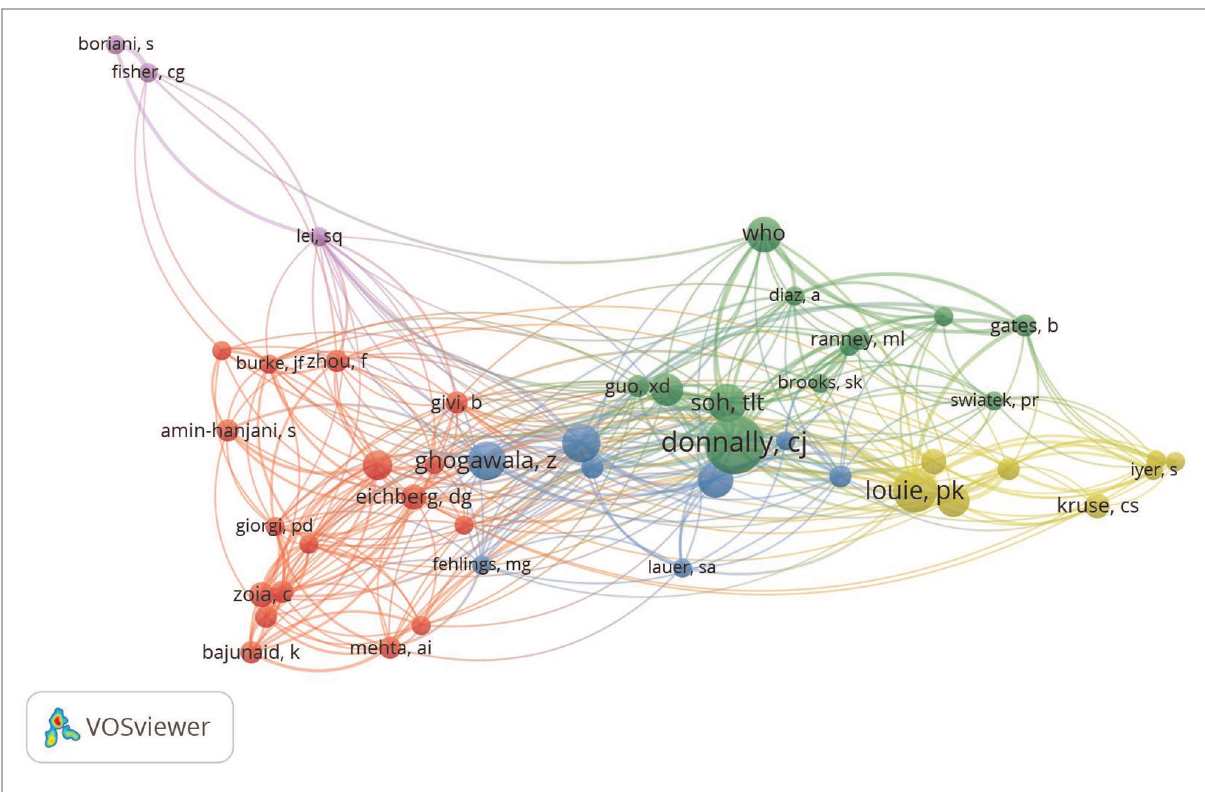
FIGURE 7 Visualization map of author co-citation